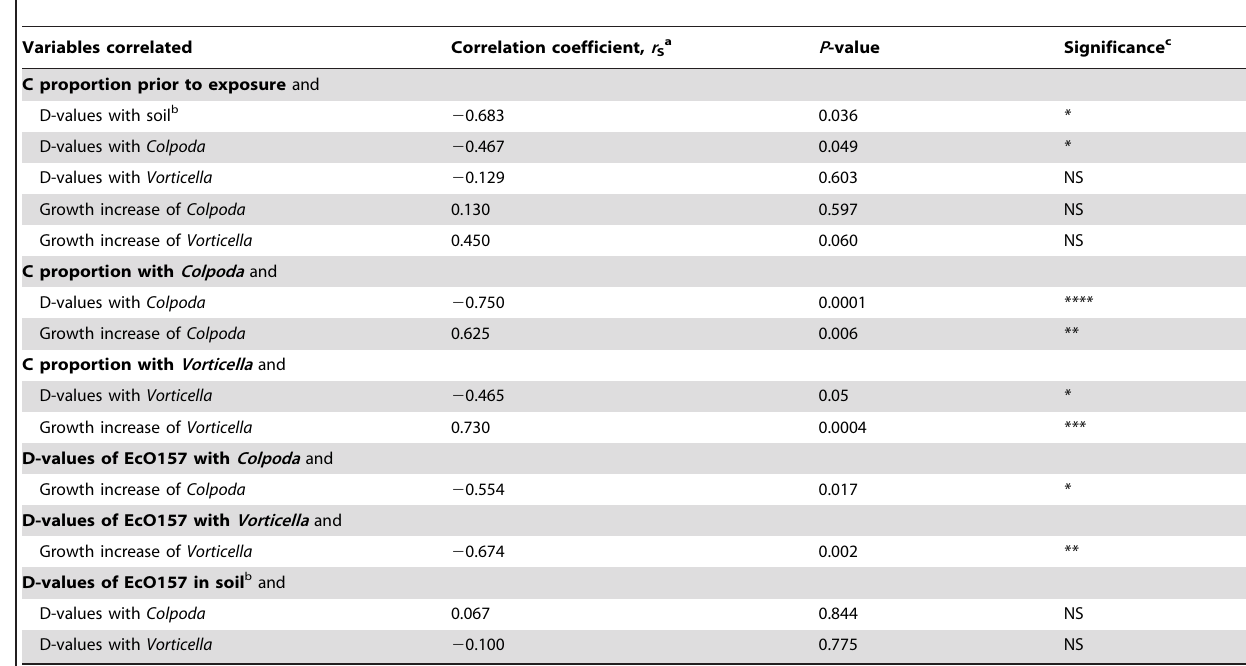
Table 2. Influence of C-variant proportions on the survival of EcO157 strains before or after exposure to protozoa and in soil from a spinach